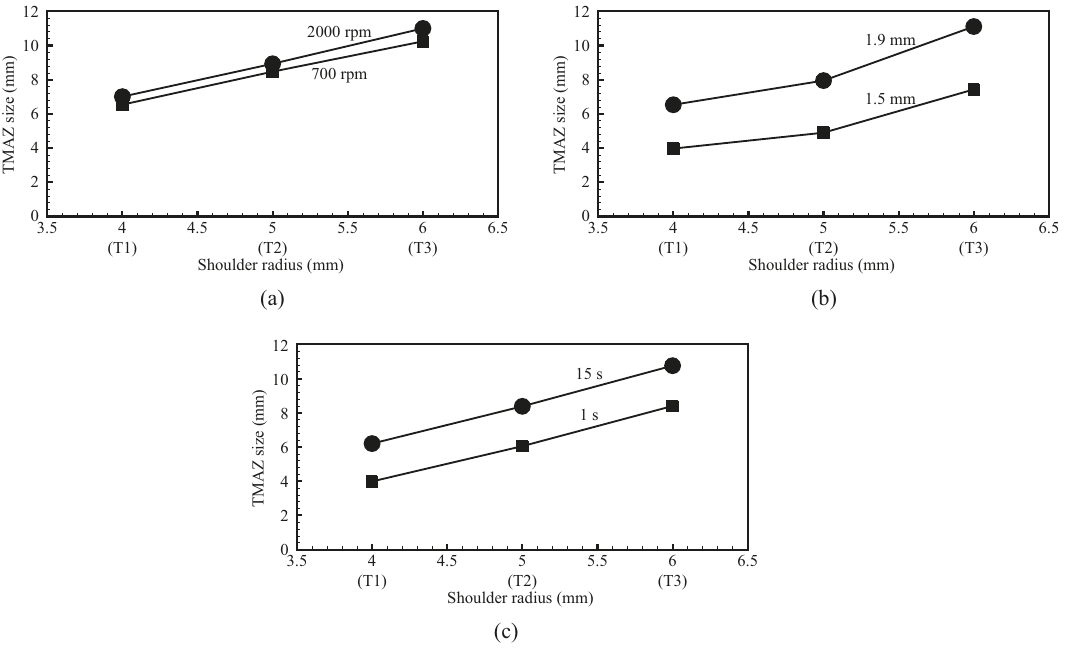
Figure 7. TMAZ sizes of FSSWs made by the three weld tools at ( a ) rotational speeds of 700 and 2000 rpm; ( b ) indentation depths of 1.5 and 1.9 mm; and ( c ) dwelling times of 1 and 15 s. Table 3. Processing parameters of the FSSWs shown in Figure